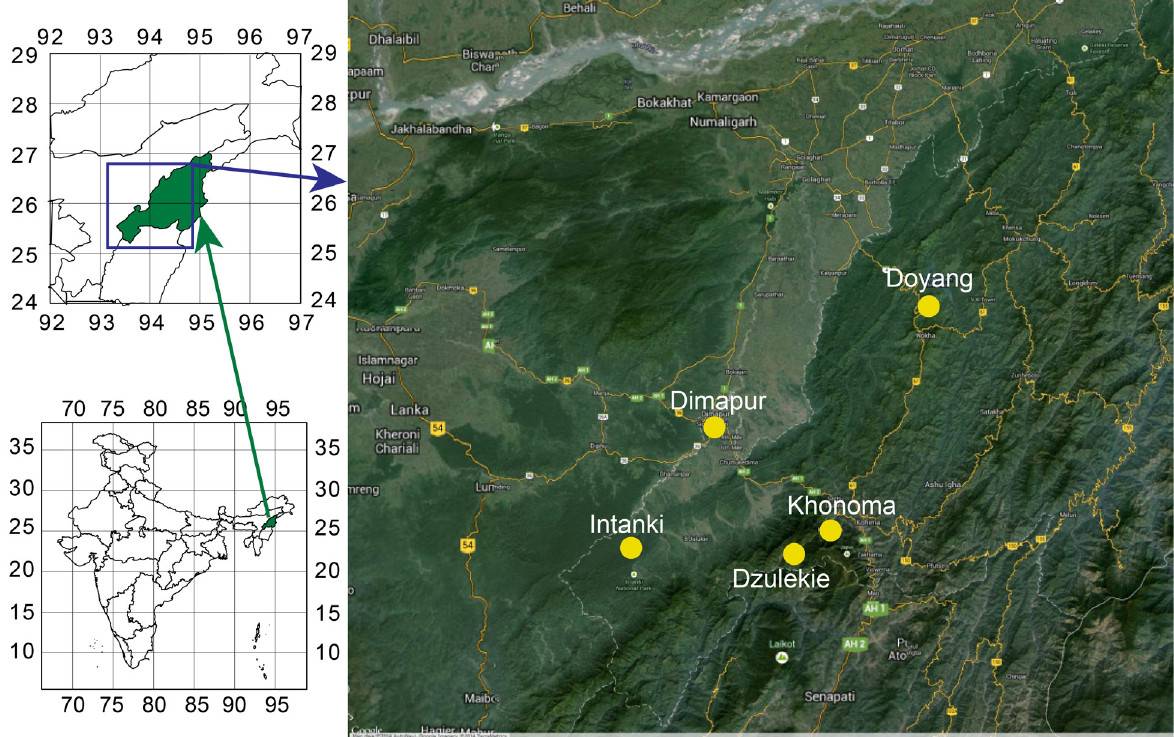
Image 1. A reference map of India with the study localities